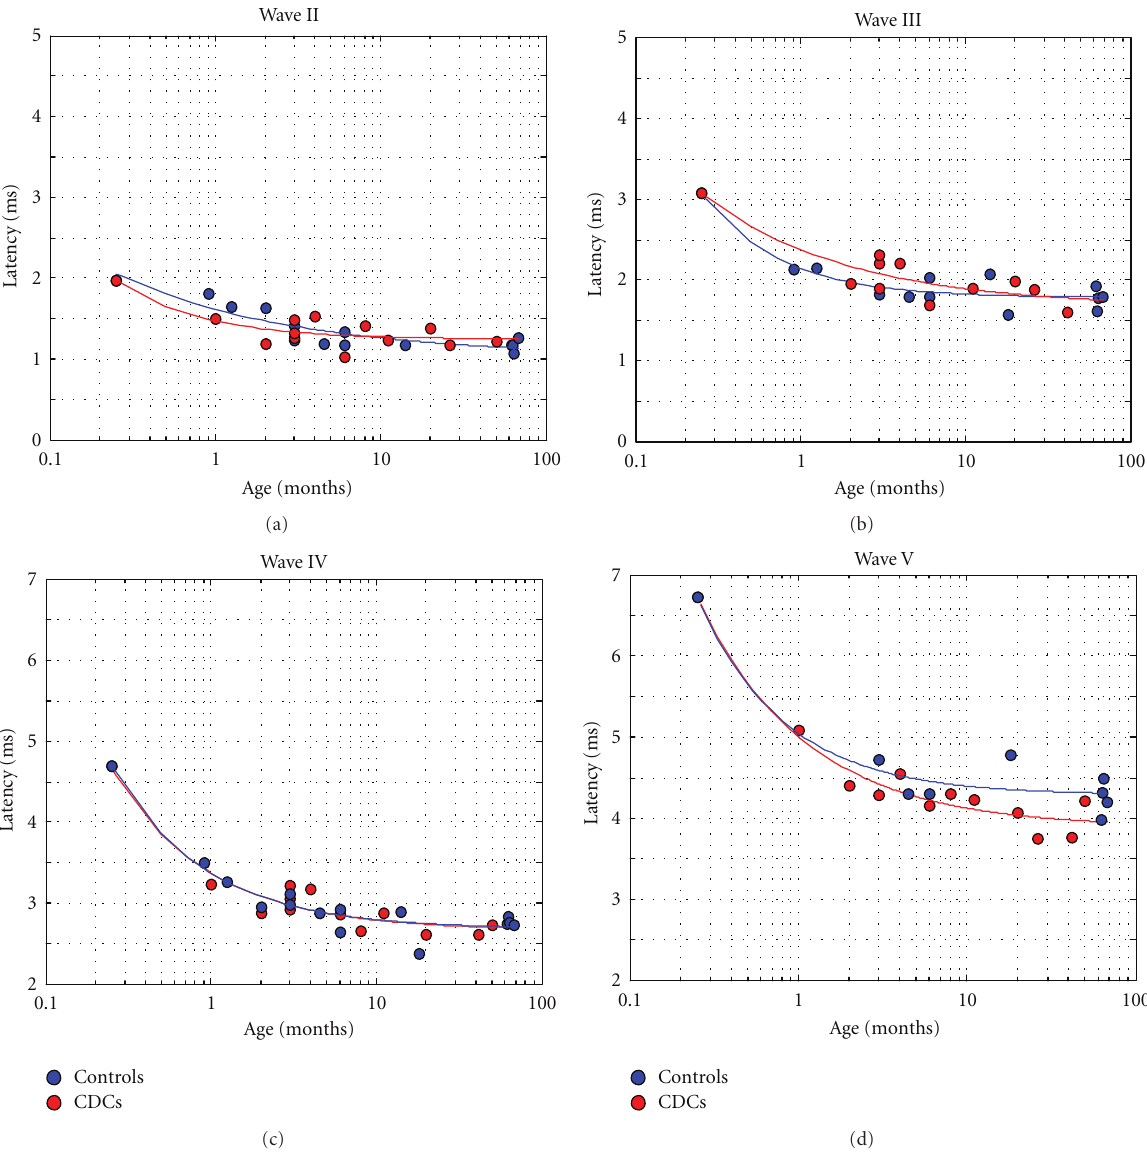
Figure 4: Development of wave latencies in hearing controls and CDCs, shown are peak latencies from all animals. Not in every animal all waves could be identified. The animal recorded at day 8 p.n. (before hearing onset) was considered a common starting point for the development in both groups. Systematic di ff erences between animal groups were not observed, only in wave V had a tendency toward shorter latencies in